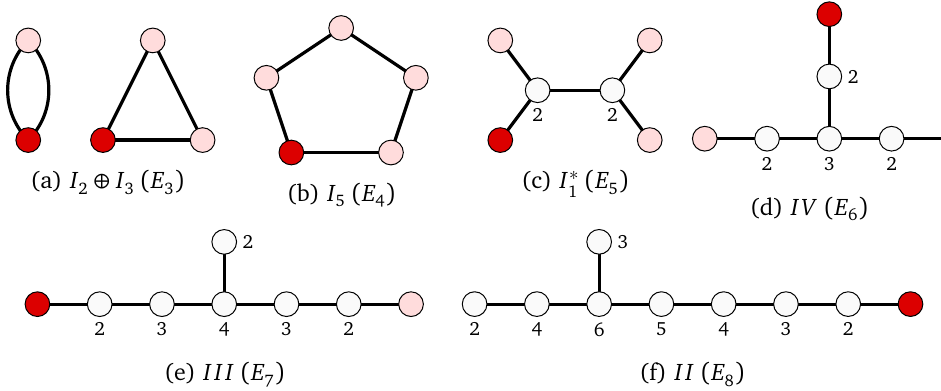
Figure 2: Examples of affine Dynkin diagrams corresponding to resolved Kodaira